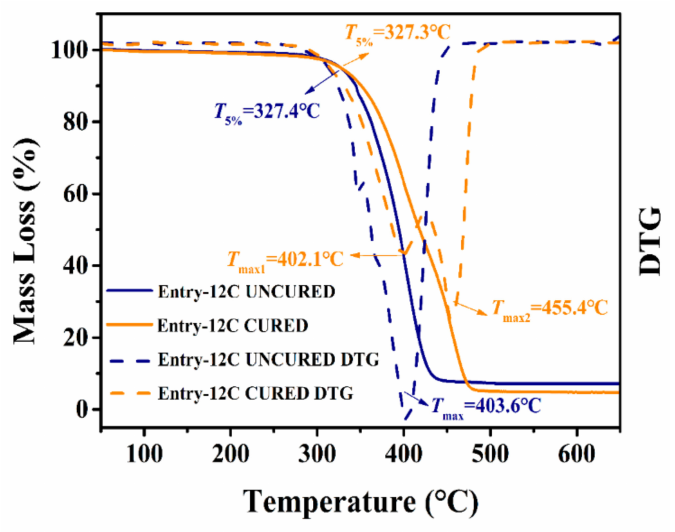
Figure 7. TG and DTG of NWCPE and cured polyester